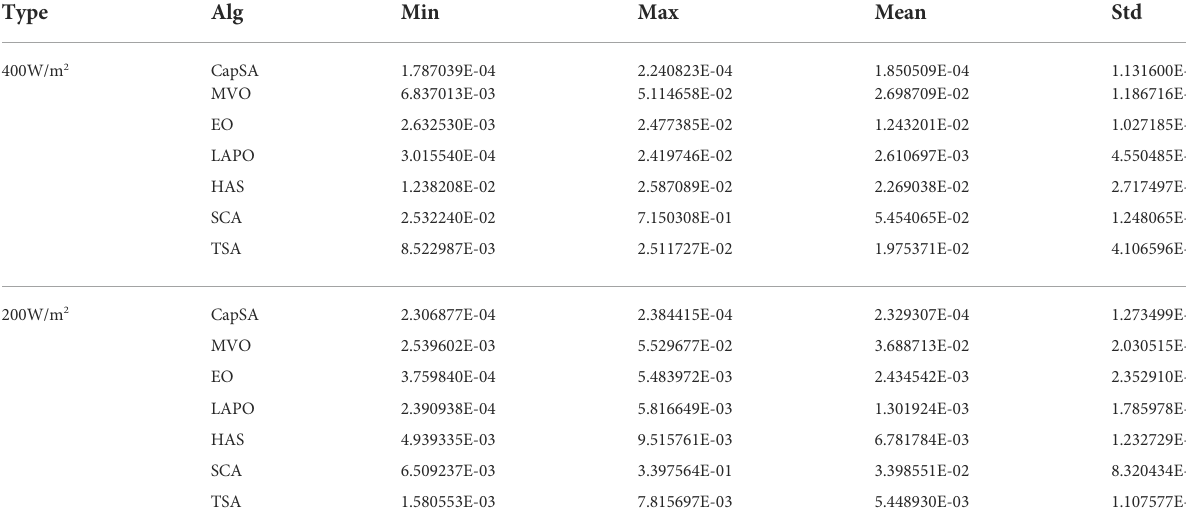
Figure 10. Figure 11 illustrates the I – V and P – V curves of the measured and simulated data obtained by the proposed CapSA at 25 ° C and different irradiances of 1000W/m 2 , 800W/m 2 , 600W/m 2 , 400W/m 2 , and 200W/m 2 . The simulated data are closely matched to the measured points. Additionally, the statistical analysis under different temperatures and irradiances are tabulated in Table 11 and Table 12,